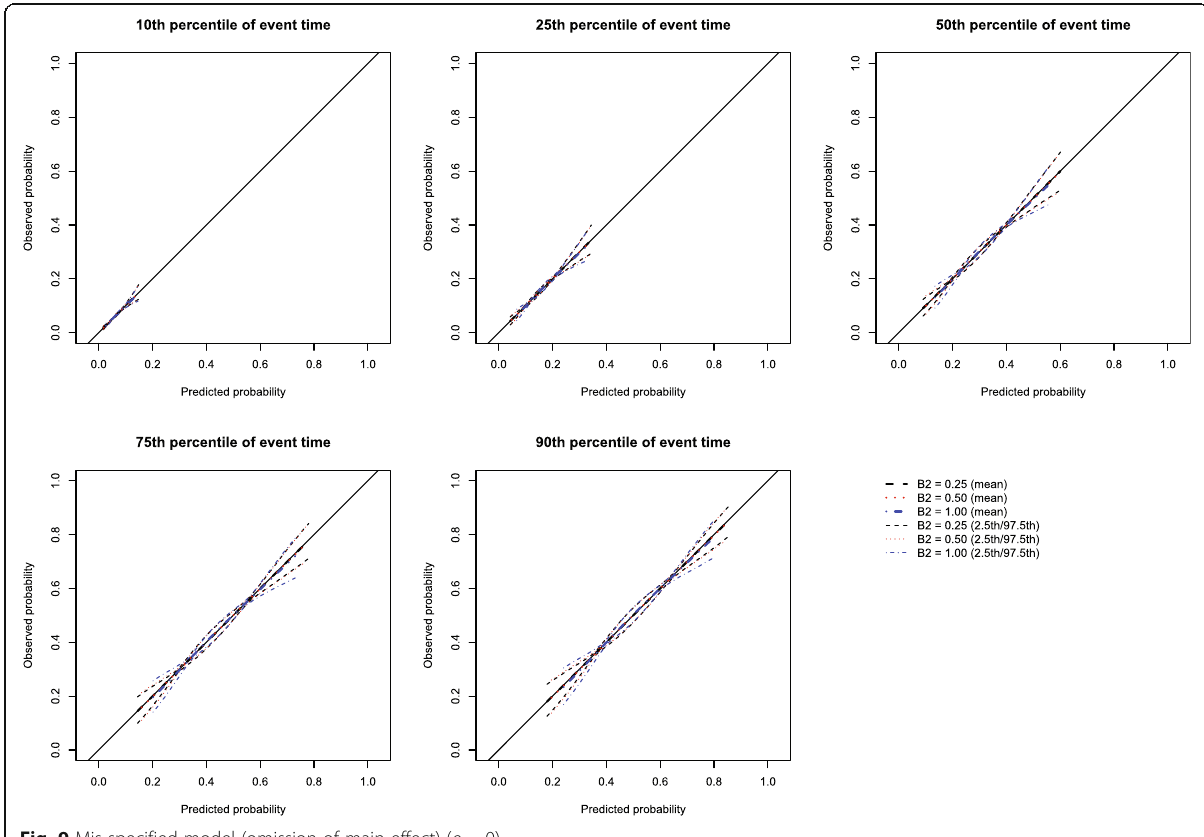
Fig. 9 Mis-specified model (omission of main effect) ( ρ =